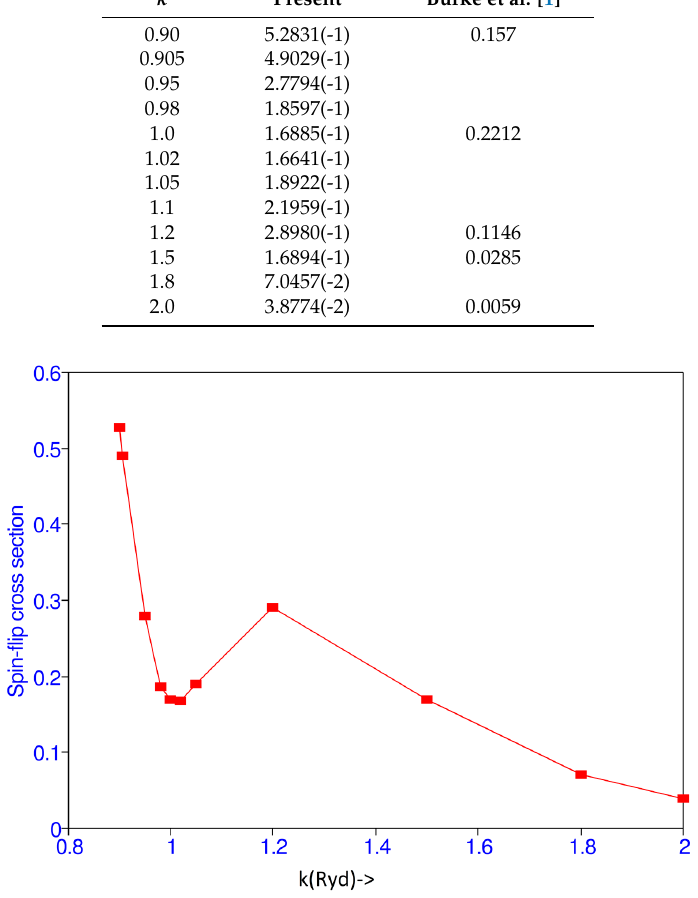
2 a π vs. the incident momentum k (Ryd). ) vs. the incident momentum k 0 0